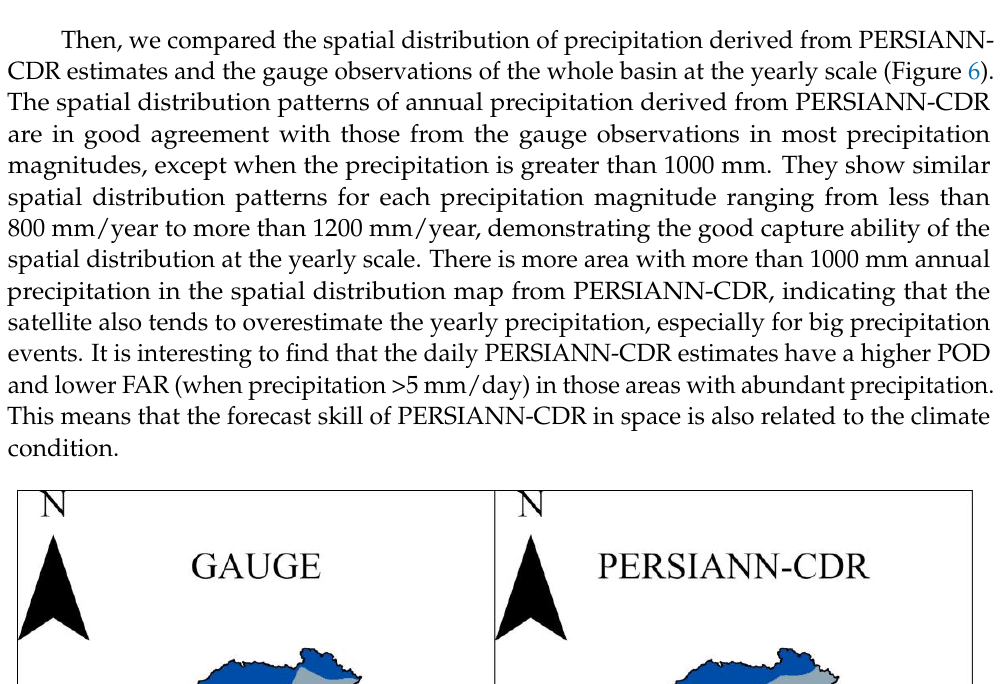
Figure 5. Comparison between PERSIANN-CDR estimates and gauge observations of ( a ) daily precipitation frequency in different magnitudes and ( b ) precipitation amounts in different seasons.